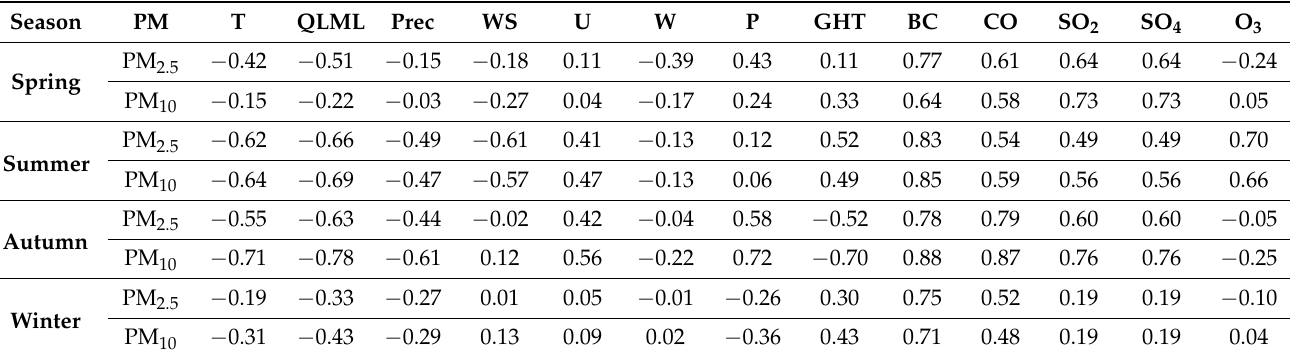
Table 1. Spearman’s rank correlation coefficients between the PM 10 and PM 2.5 concentrations and the meteorological factors and pollutants by season. Here, PM = particulate matter concentrations, T = temperature, QLML = specific humidity, Prec = precipitation, WS = wind speed, U = horizontal wind vector, W = vertical wind vector, P = pressure, GHT = ground